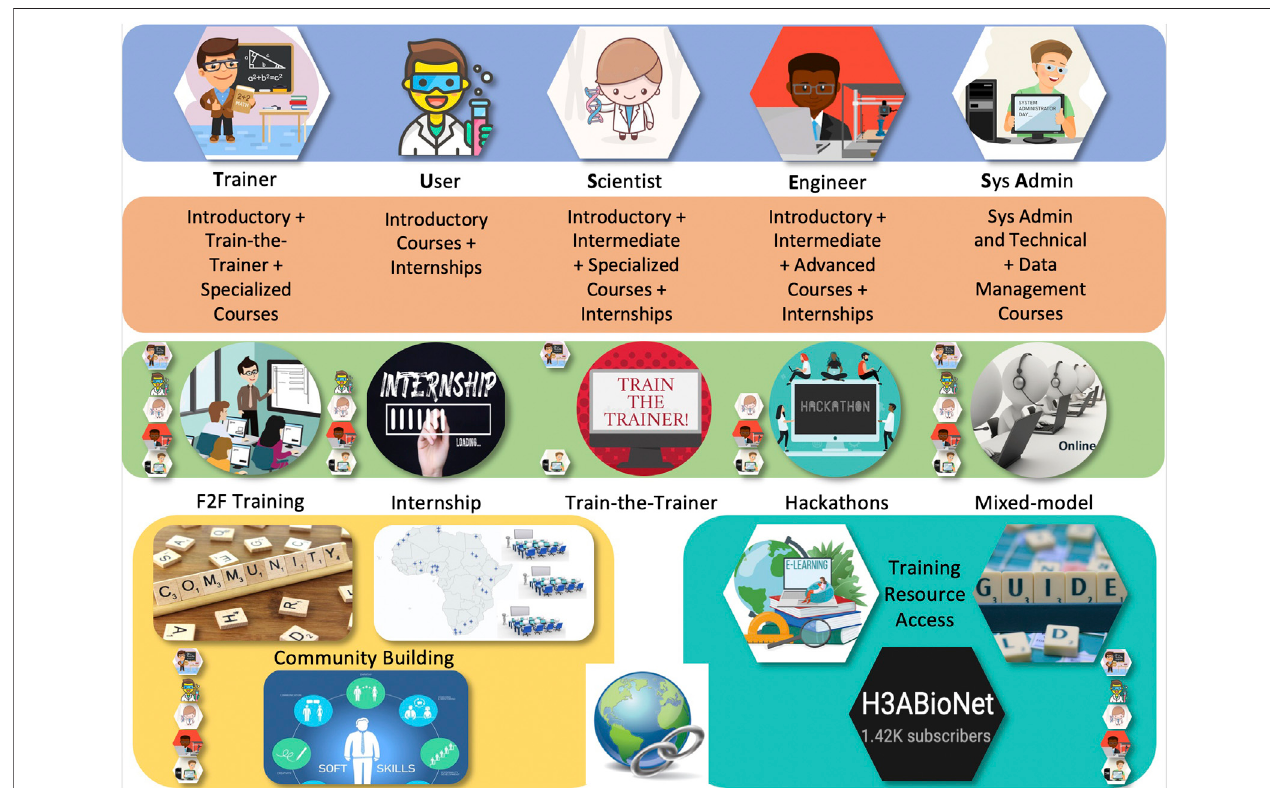
FIGURE2| AdiagrammaticrepresentationoftheH3ABioNettrainingenvironment.Thebluebar( fi rsttier)representsthedifferentaudiences(personas)identi fi edas necessarytodevelop withinthe network.Theimage ofeach persona isused torepresent thechoiceoftrainingapproach/resource inthe fi gure.Courses weredesigned and presented at varying levels of dif fi culty (red bar — second tier) to allow for progressive growth of individuals based on their desired backgrounds and planned career paths. Similarly, thecomplementary modes ofteaching(green bar — third tier) presented the opportunity forindividualstoexplore and learn inunique environments that fostered the support and opportunities required to develop speci fi c competencies and personas. The fourth tier (yellow block) of the training environment provides individuals with the opportunity to learn as part of a larger community as opposed to individual silos and further develop the complementary skills required to excel in buildingasuccessfulacademiccareer.The fi nalcomponent(tealblock)highlightsoureffortstomakeourtrainingresourcesaccessiblebeyondH3ABioNettoensurethat the efforts to continue training in bioinformatics are sustainable and continue to be utilised by the broader bioinformatics